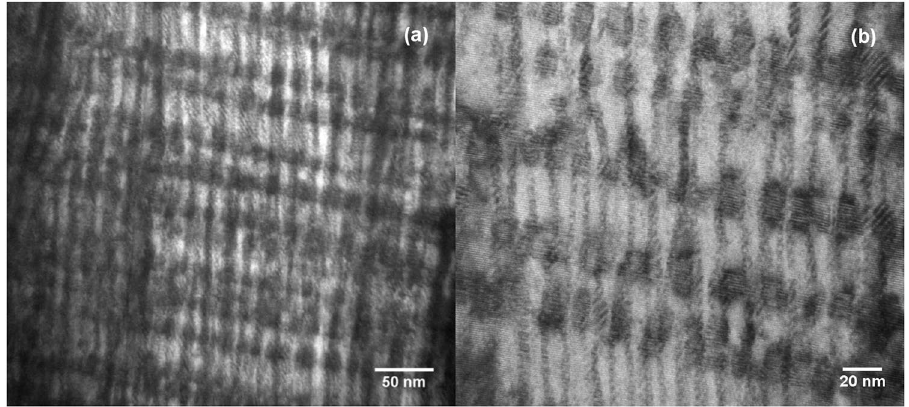
Figure 1. Cross-section TEM microstructure of a 4.8 µ m thick REBCO tape with 15 mol% Zr addition at two magnifications, showing well-aligned BaZrO